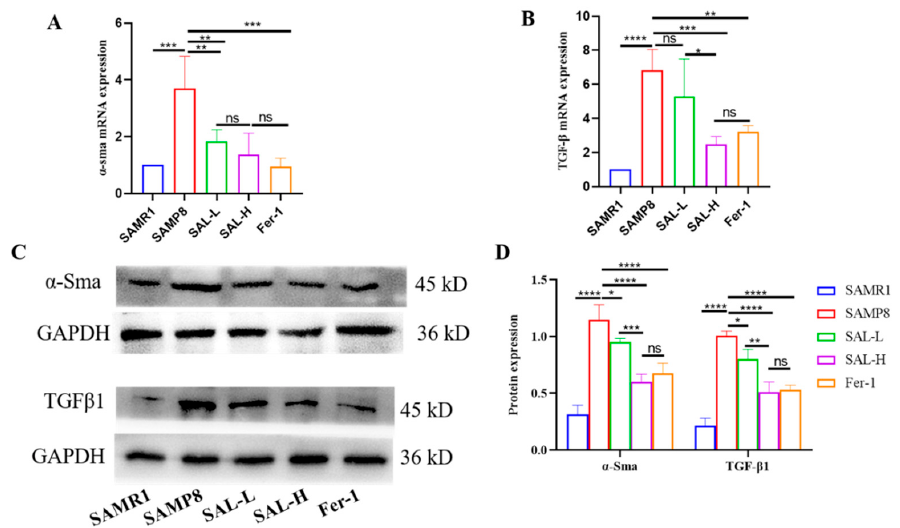
Figure 6. Effects of SAL on expressions of α -SMA and TGF- β 1 in renal tissue of SAMP8 mice (Western blot and q-PCR). ( A ) The relative expression of α -SMA. ( B ) The relative expression of TGF- β 1. ( C , D ) Western blot analysis of α -SMA and TGF- β 1 expression, and quantification in the kidney. Data are expressed as means ± SD, * p < 0.05, ** p < 0.01, *** p < 0.001, **** p < 0.0001.